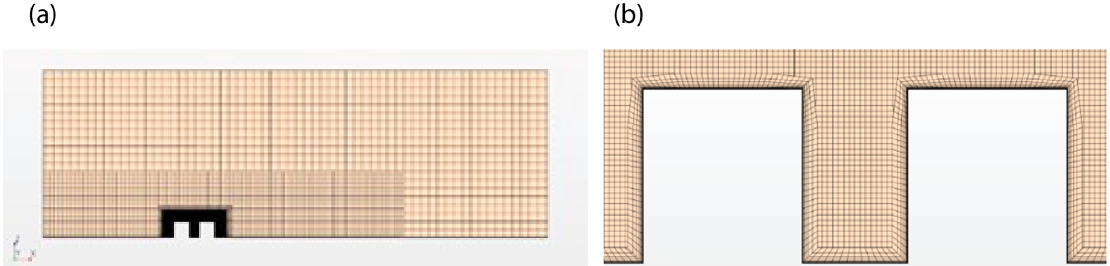
Figure A1. Example of mesh zones ( a ) and grid refinement near walls ( b ).